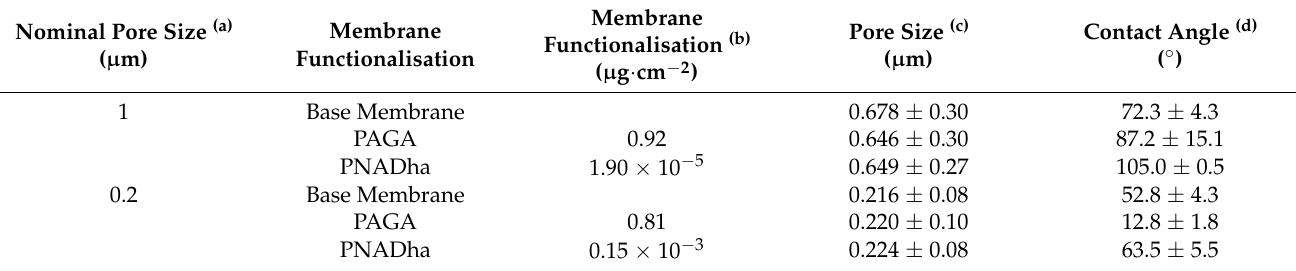
Table 1. Characterisation of the surface grafted membranes using electron microscopy and contact angle. Membrane Nominal Pore Size (a) ( µ m)